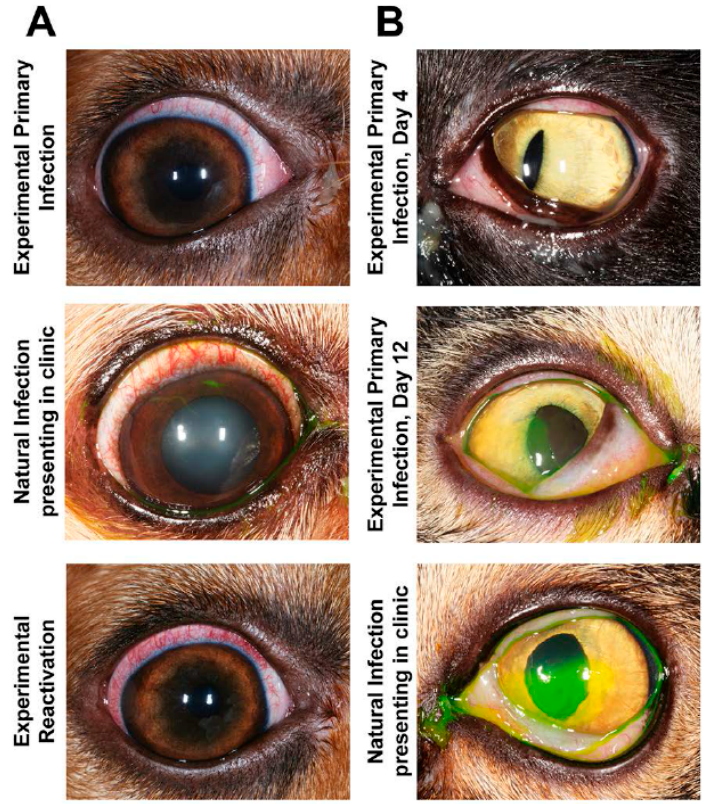
Figure 4. Clinical presentation of experimental and clinical infection of ocular herpesviruses in dogs and cats. ( A ) Representative CHV-1-associated ocular disease in dogs at day 10 post primary experimental infection, natural infection presenting to the clinic, or at day 7 post reactivation with systemic prednisolone. Experimentally infected dog eyes were stained with lissamine green, although no retention in either dog was observed. Naturally infected dog eyes were stained with fluorescein dye to visualize corneal ulcers; ( B ) representative feline herpesvirus type 1 FHV-1-associated ocular disease in cats following primary experimental infection at day 4 post infection, with conjunctivitis only and at day 12 post infection, with both corneal ulceration and conjunctivitis, or natural infection presenting to the clinic with both corneal ulceration and conjunctivitis. Cat eyes were stained with fluorescein dye to visualize corneal ulcers.